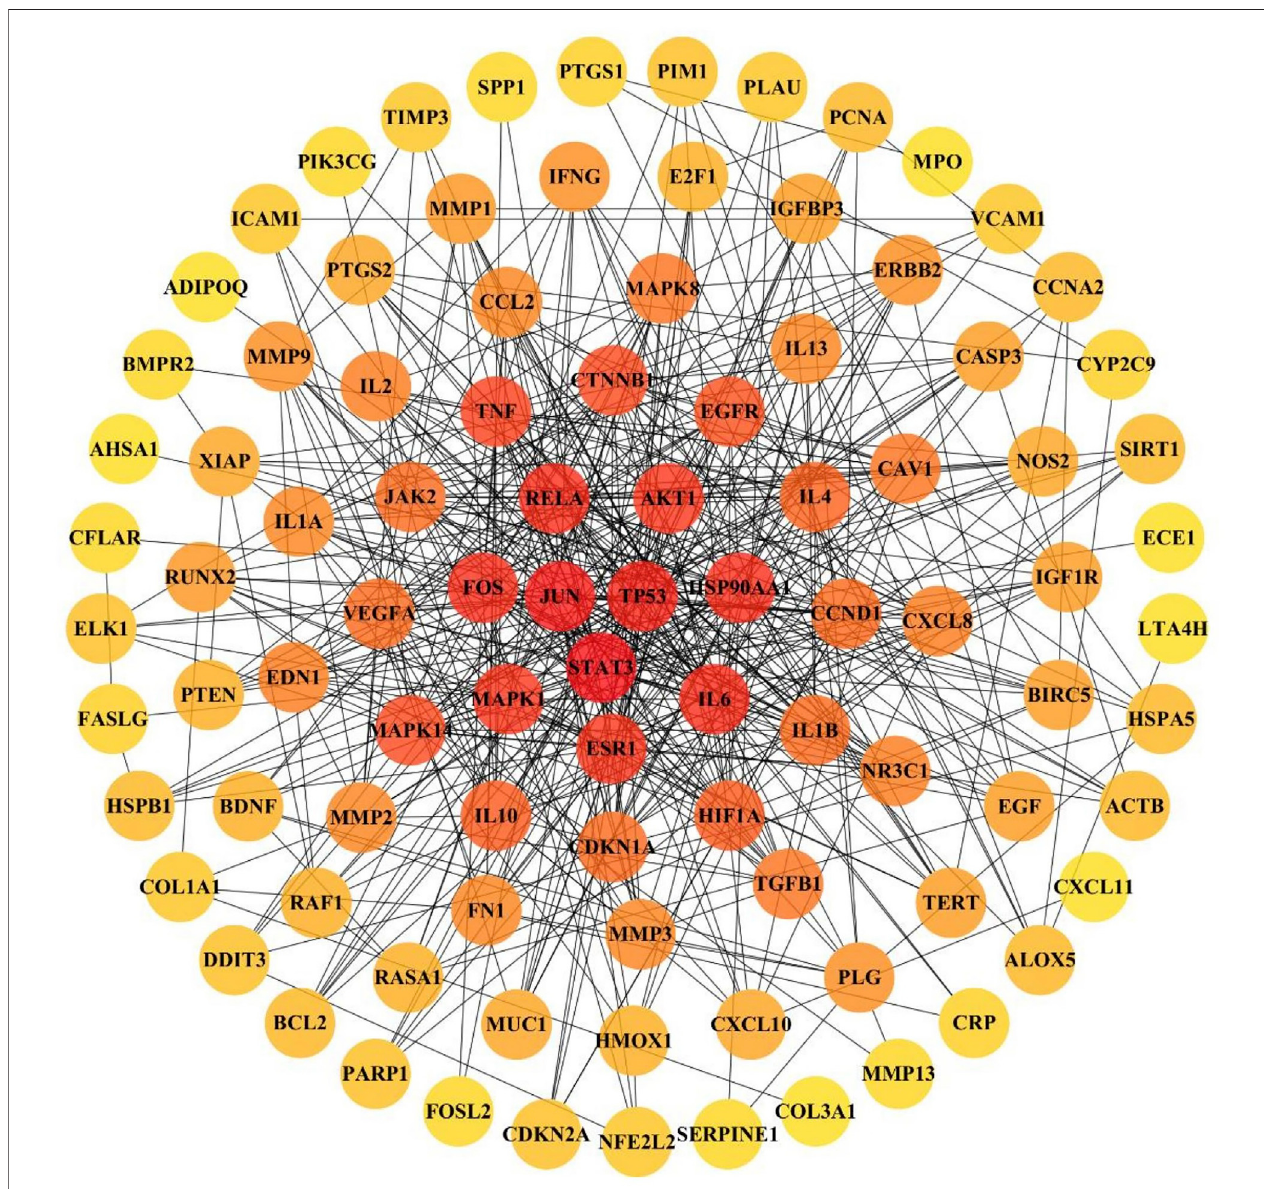
FIGURE 4 | The PPI network of overlapping targets between IPF and JBOL. 103 overlapping targets were plotted as nodes. The edges represent the interaction relationships between the nodes. The darker node color indicates a higher degree value.